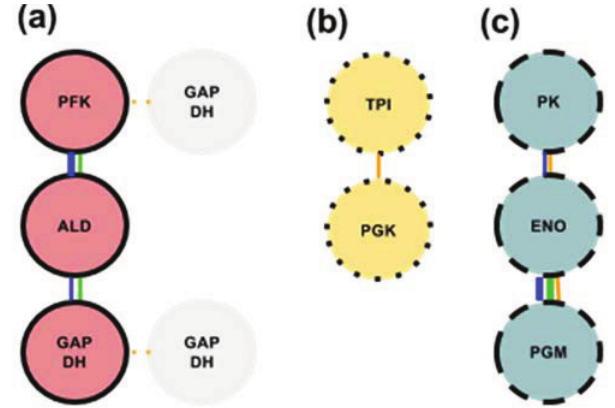
Figure 2. ( a ) GlySCx1 denoted by intact black borders and red interior with the second possible GAPDH in gray at the two possible positions, ( b ) GlySCx2 with members denoted by dotted borders and yellow interior, ( c ) GlySCx3 with members denoted with dashed borders and blue interior. Connecting lines represent a specific interaction between the enzymes with the color relating to the type of study that has shown an interaction (see Table 1 for color code). Interactions that are supported by three or more studies are indicated with a thick line and interactions that are supported by less than three studies are indicated with a thin line. Each circle represents an entire functional enzyme (subunits